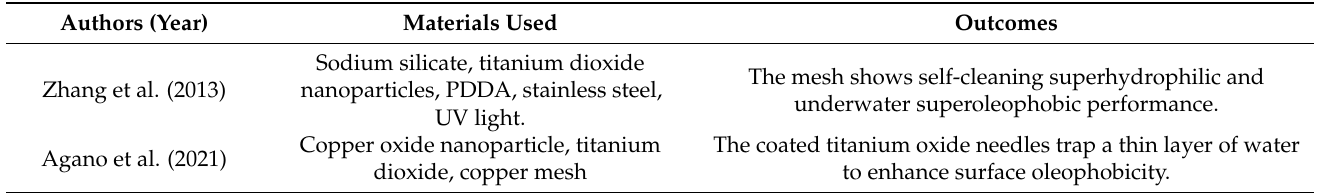
Table 10. Recent studies on meshes coated with superhydrophilic materials for various